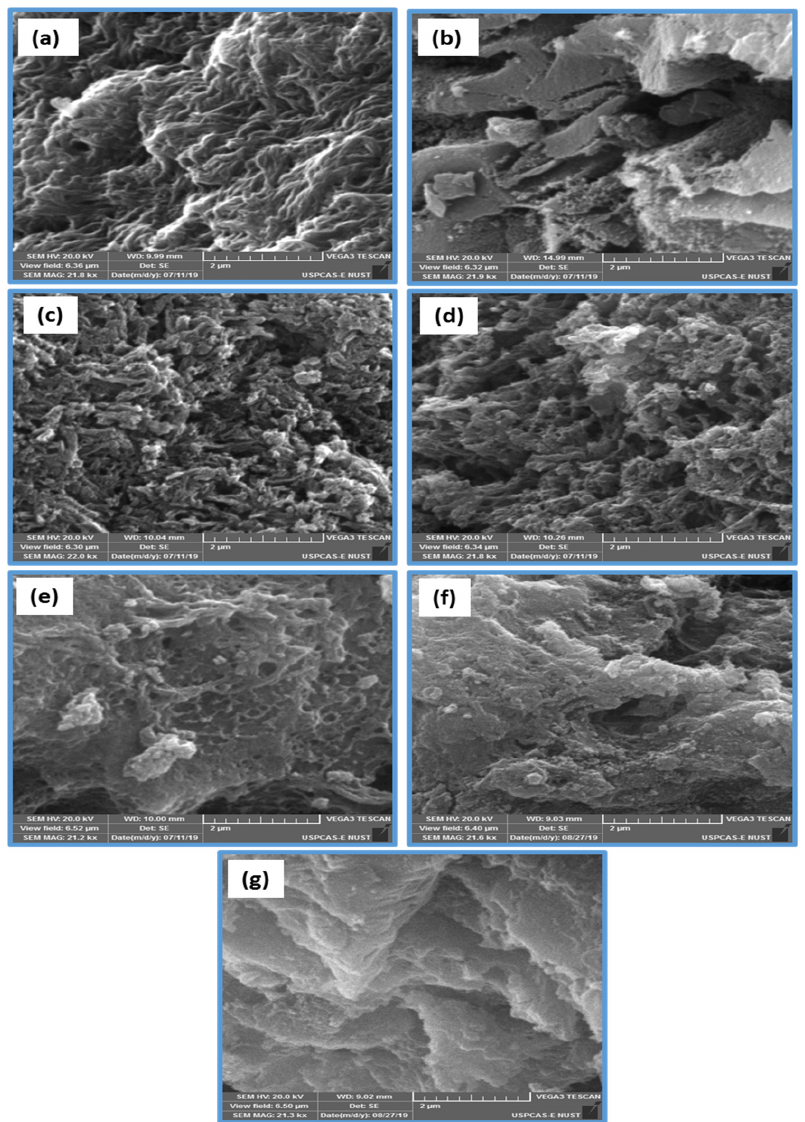
Figure 2. SEM micrographs of ( a ) PIN, ( b ) AC, and ( c ) AC@PIN-1, ( d ) AC@PIN-2, ( e ) AC@PIN-3, ( f ) AC@PIN-4 composite before adsorption, and ( g ) AC@PIN-3 after adsorption at the magnification of 2.0 μ m.